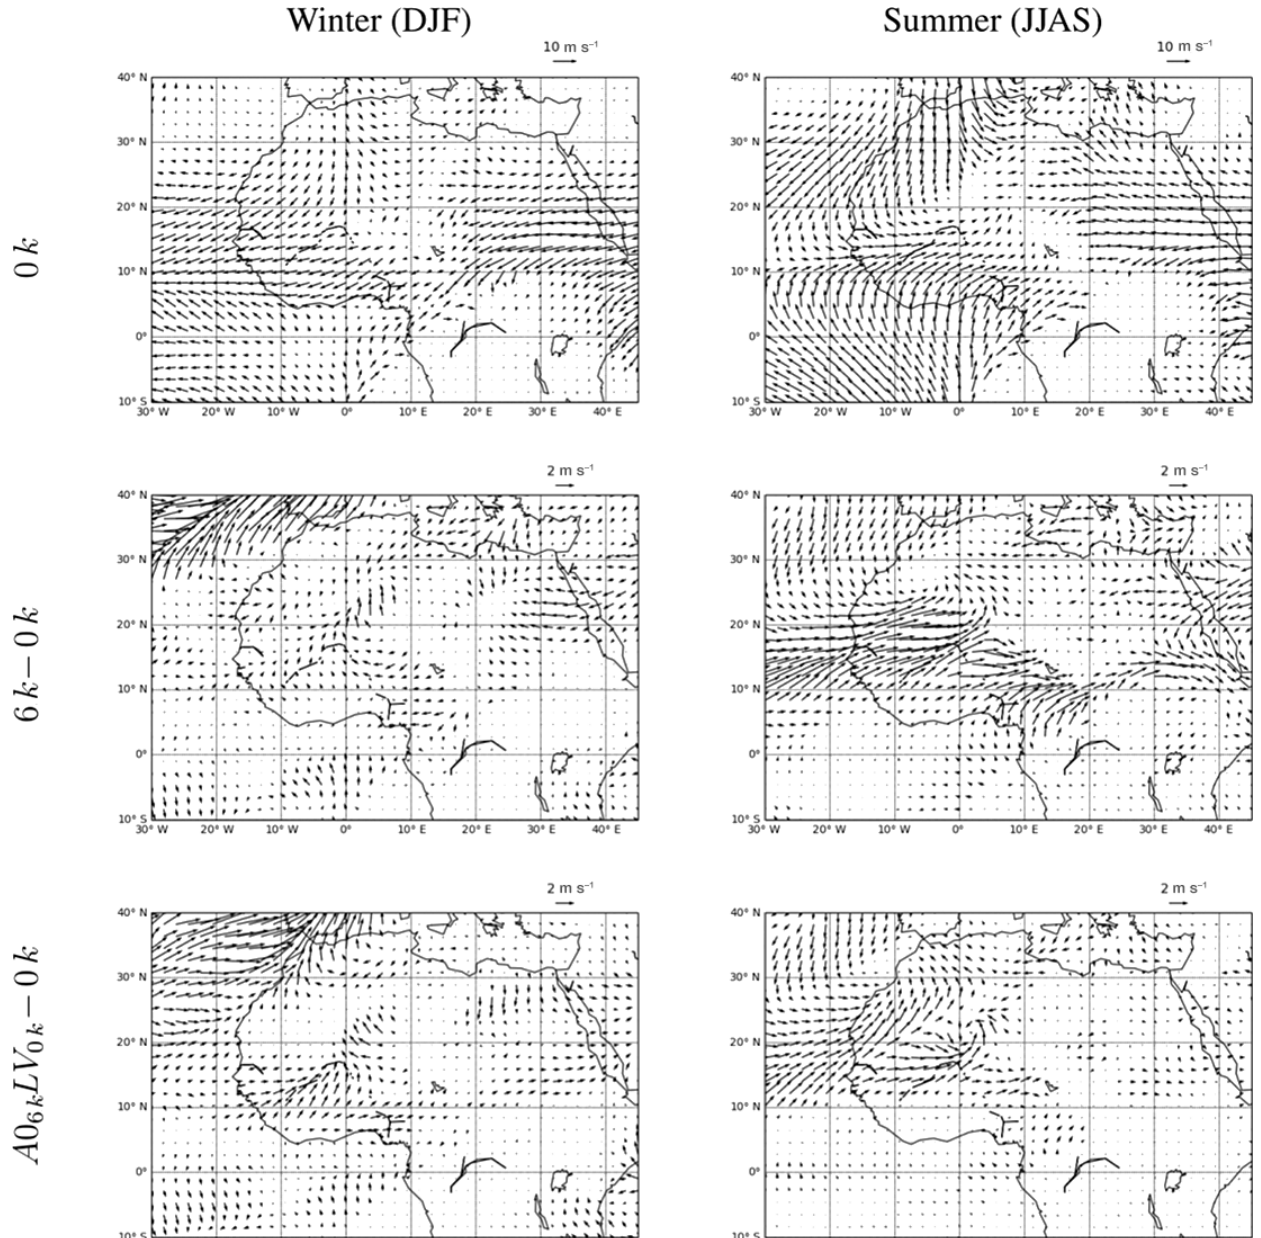
Figure A1. Simulated 10m surface wind speed and directions for winter (DJF; left) and summer (JJAS; right) for 0 k and for the differences 6 k –0 k and A0 6 k LV 0 k − 0 k